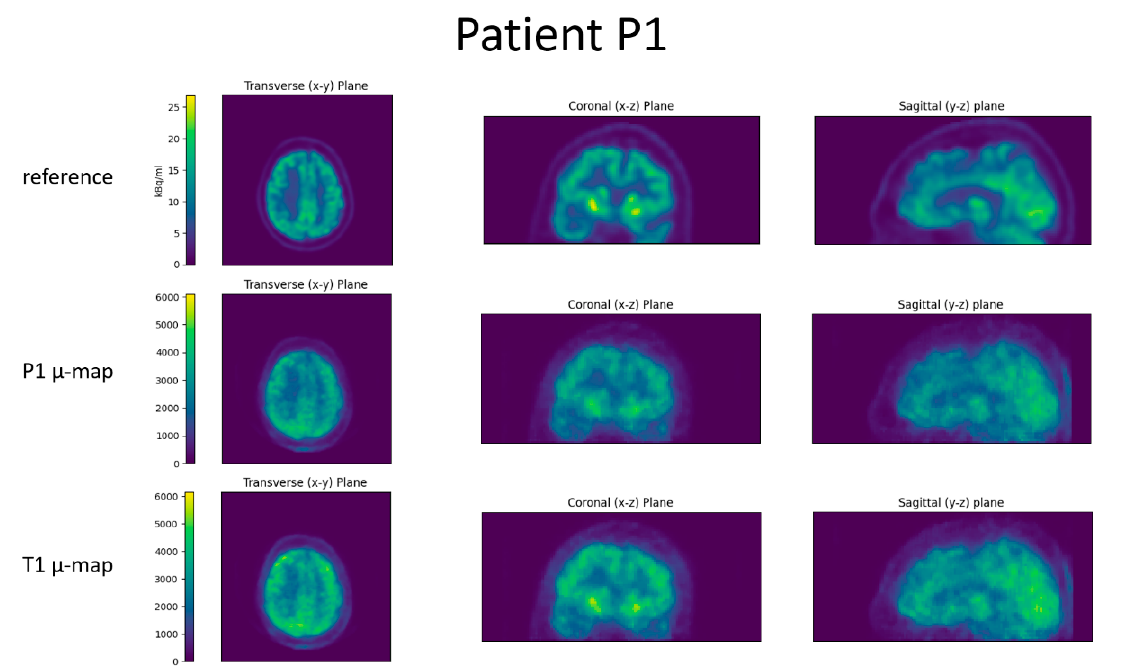
Figure 6. Slices through the reconstructed images for patient P1. Top row is the reference PET scan, middle row the BPET reconstruction using the patient-specific µ-map (from CT of patient P1), bottom row the BPET reconstruction using an independent template µ-map fitted with the method presented in this article.